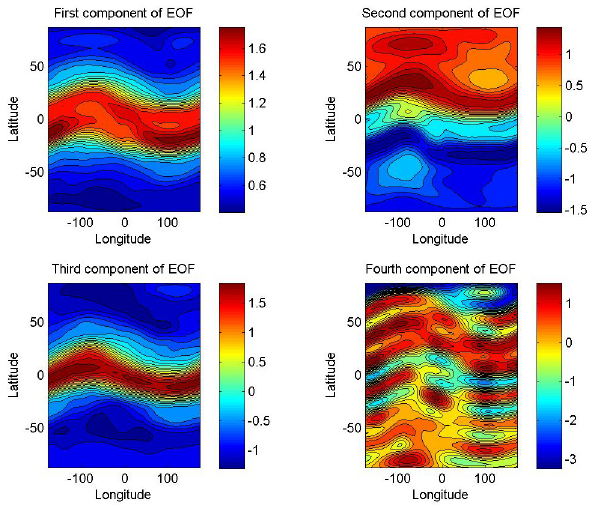
Figure 2. First four EOFs for the 11-year daily averaged global TEC as functions of longitude and geographic latitude calculated by the spatial and temporal settings given in Fig.